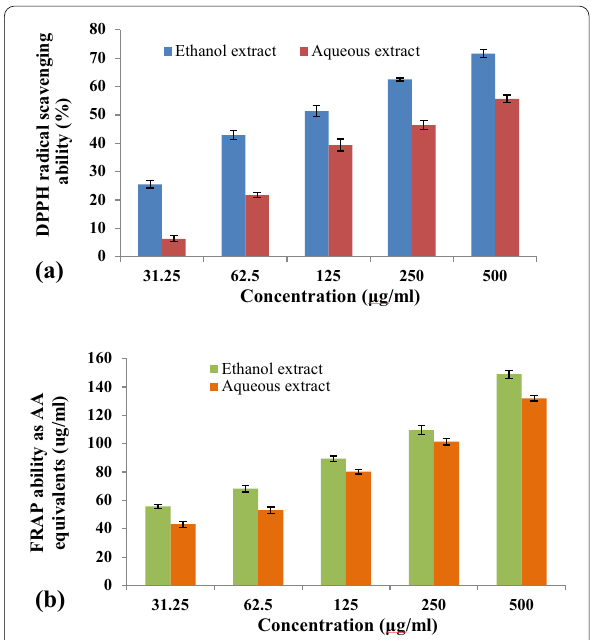
Fig. 1 DPPH radical scavenging activity ( a ) and Ferric reducing antioxidant power ability ( b ) of Suaeda maritima leaf